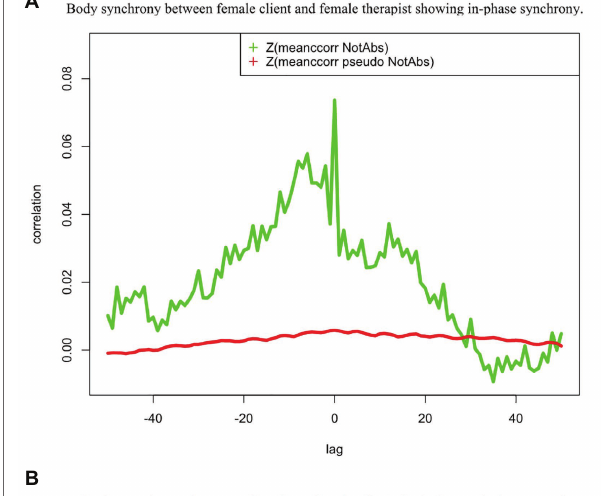
TABLE 5 | The differences in the means between head and body synchrony for the three different types of dyads.